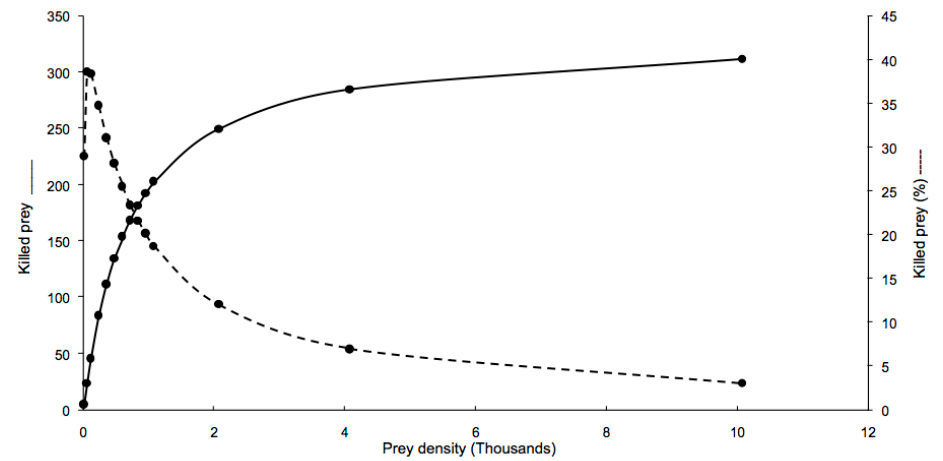
Figure 4. Functional response curve fit by non-linear least-squares regression of Pseudoophonus rufipes adults attacking Ceratitis capitata larvae and sharing the experimental unit with Aganaspis daci mated females parasitizing C. capitata larvae (type III). Host density: 5, 20 or 40 larvae per P. rufipes adult and A. daci mated female (both species sharing the same experimental unit).